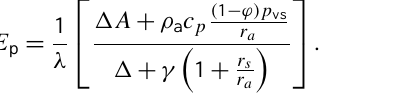
Figure 4 Fig. 4. Water retention of the investigated soil: dots represent field experimental data at various depths; the bold line is the calibrated water retention curve of the assumed single homogeneous layer; the dashed lines represent the limits of the range of water retention curves considered in the calibration